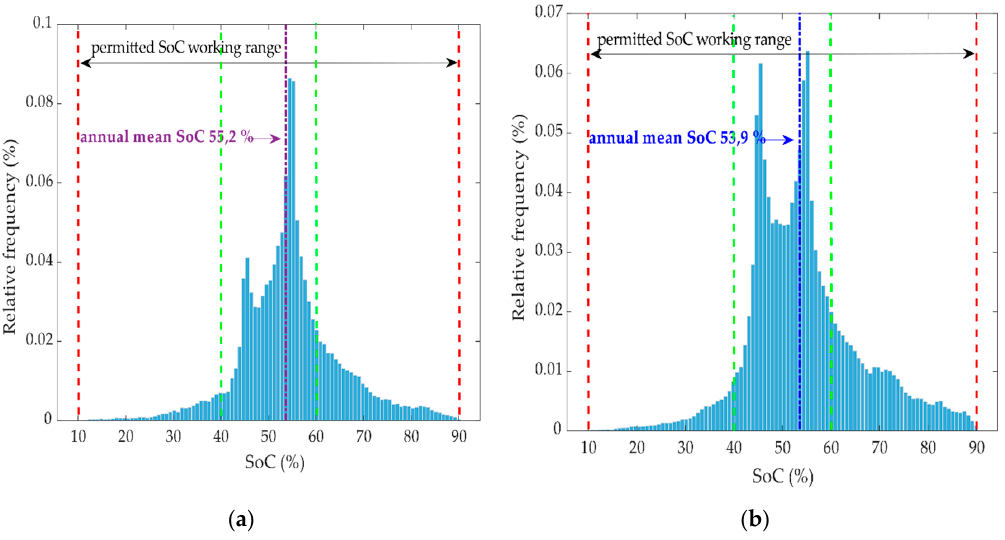
Figure 18. ( a ) Probability distribution function of the BESS SoC during 2016. ( b ) Probability distribution function of the BESS SoC during 2018.